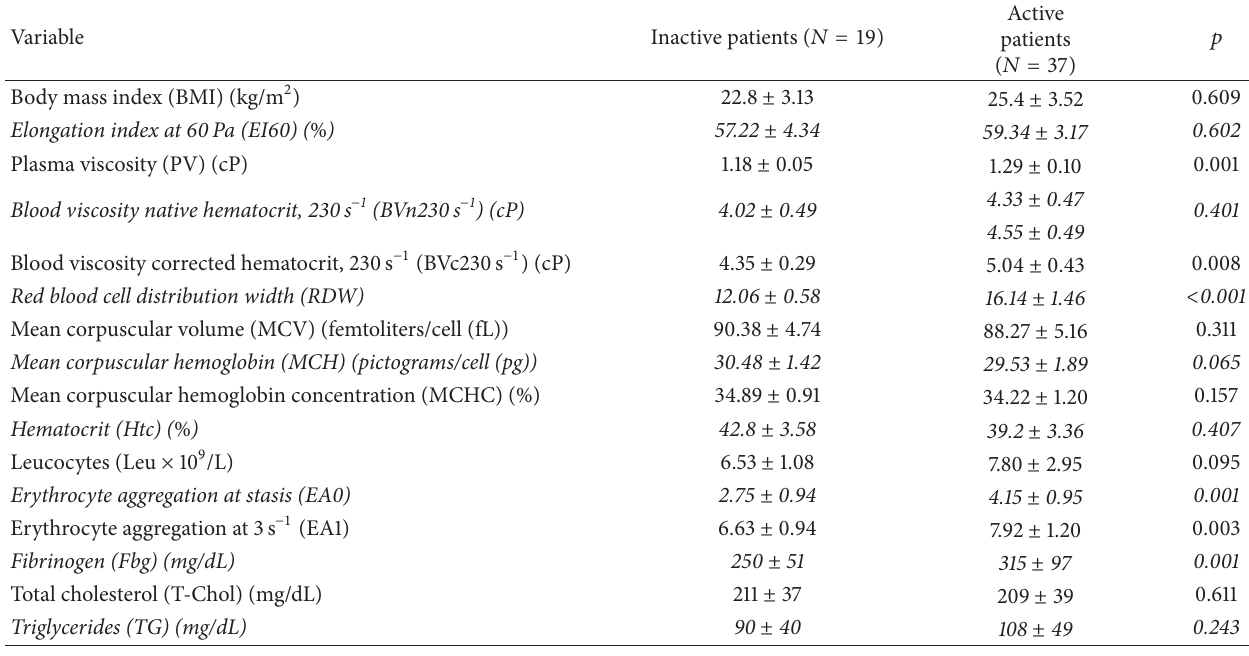
Table 5: Comparison of body mass index and biochemical and rheological parameters for inactive and active Behc¸et disease patients ( 𝑛 = 3